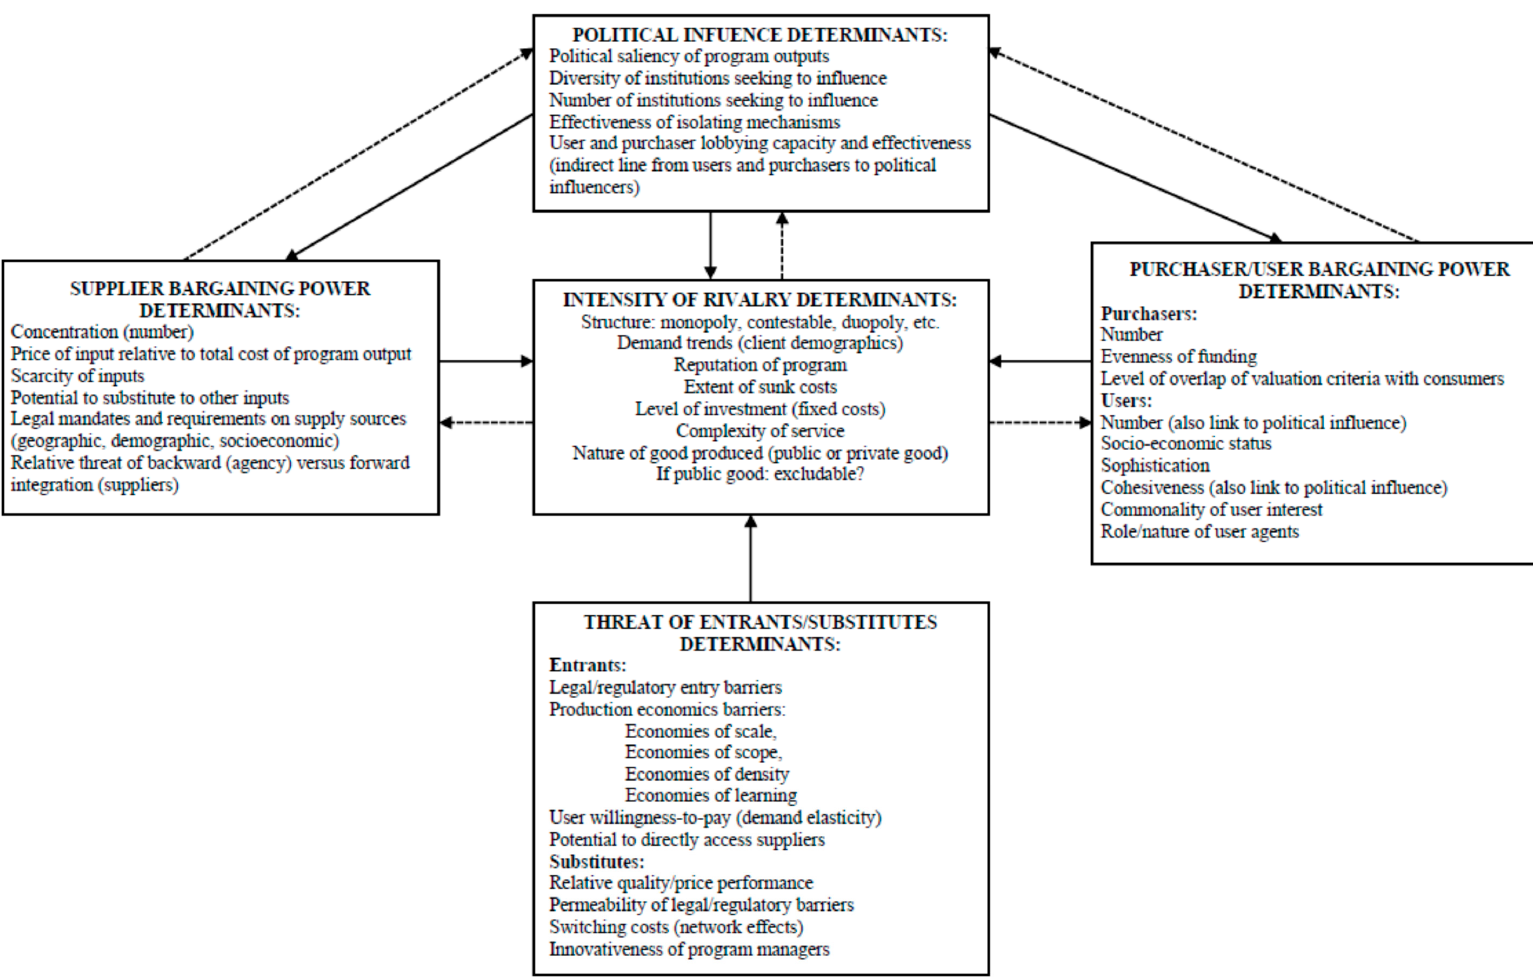
Figure 3. PASA External Forces Analysis.